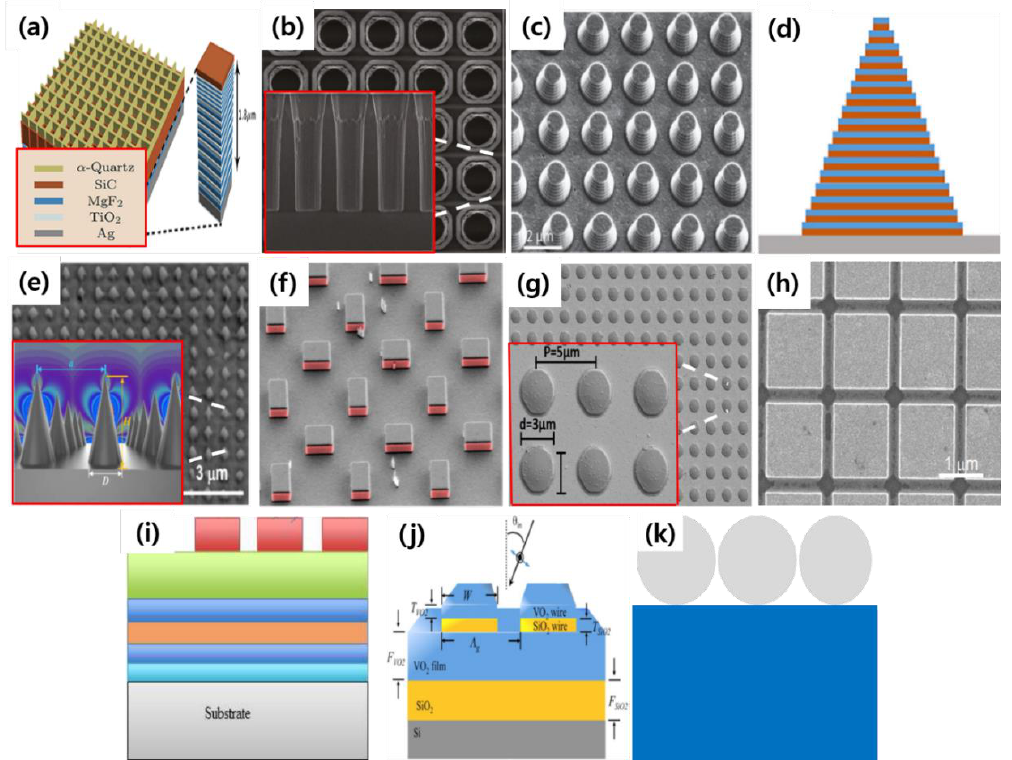
Figure 3. Various metamaterial-based radiative cooler structures: ( a ) metal-dielectric lattice structure [41], ( b ) photonic crystal structure [42], ( c ) conical shape array [43], ( d , e ) antenna structures [30,48], ( f – h ) metasurfaces [54–56], ( i , j ) gratings [57,59], and ( k ) sphere arrays [60]